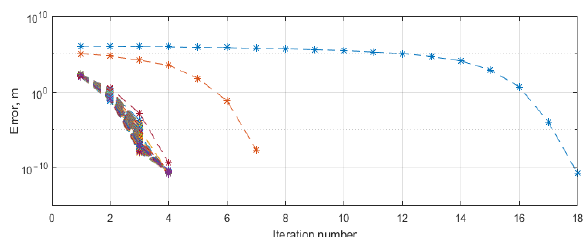
Figure 6. The error decreases rapidly as the number of iterations